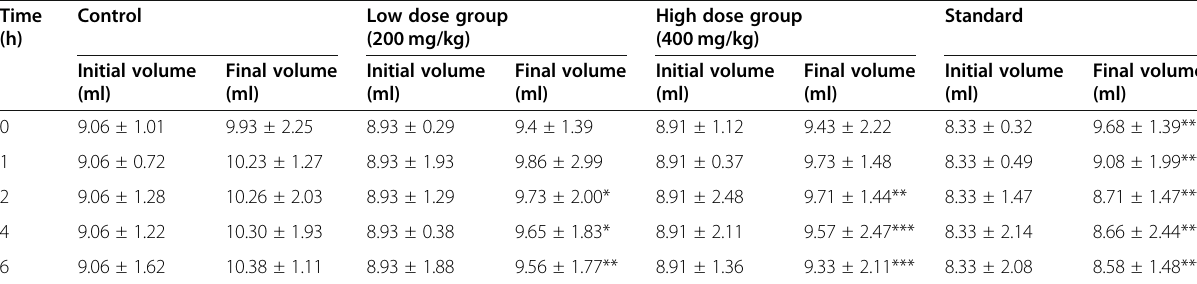
Table 4 Effect of Martynia annua extract on CPL induced paw edema in rats Time Control (h)